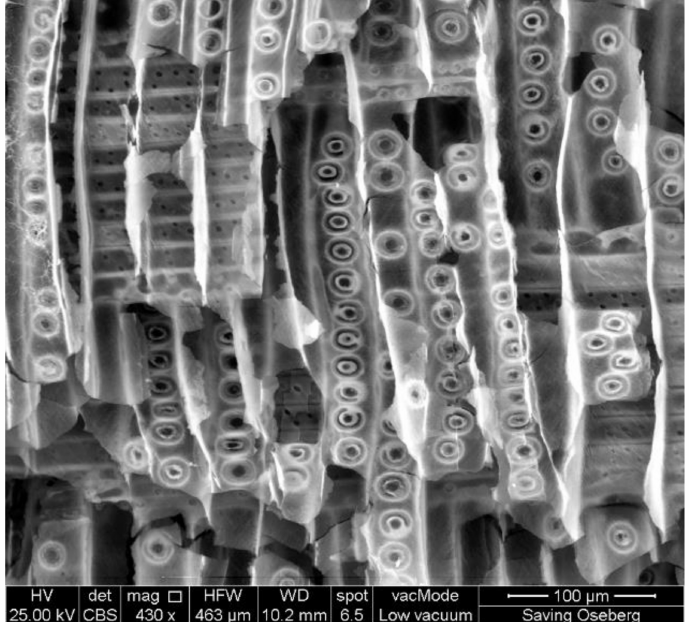
Figure 3. Scanning electron micrograph of a radial-longitudinal section from historical waterlogged Picea abies (L.) H.Karst. wood. Border pits in the longitudinal tracheids appear degraded whilst signs of attack by fungi are also visible along the tracheid lumen (left-hand side of image). The wood sample belongs to an assemblage of wooden stocks used for the construction of a road excavated from the medieval part of Oslo (ca. 1200–1300 CE). Image: A. Zisi, © Museum of Cultural History.